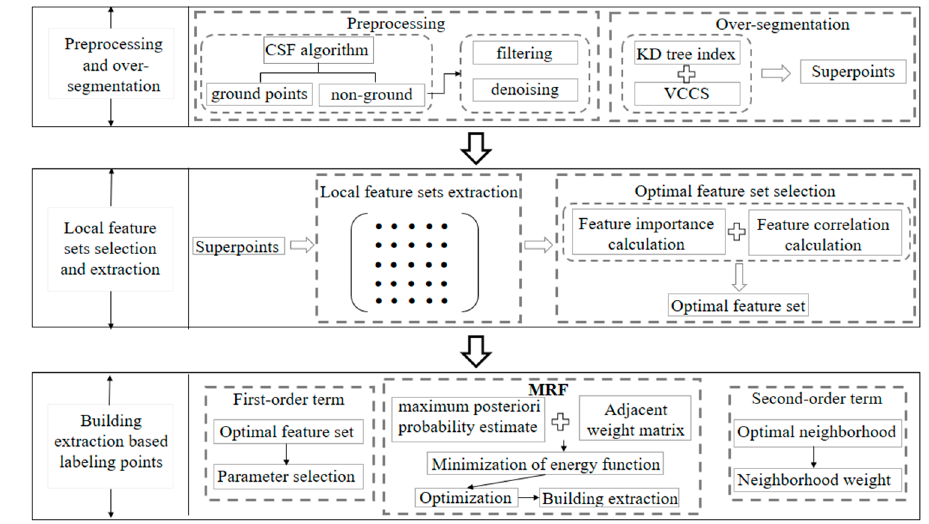
Figure 1. Overview of the proposed framework.